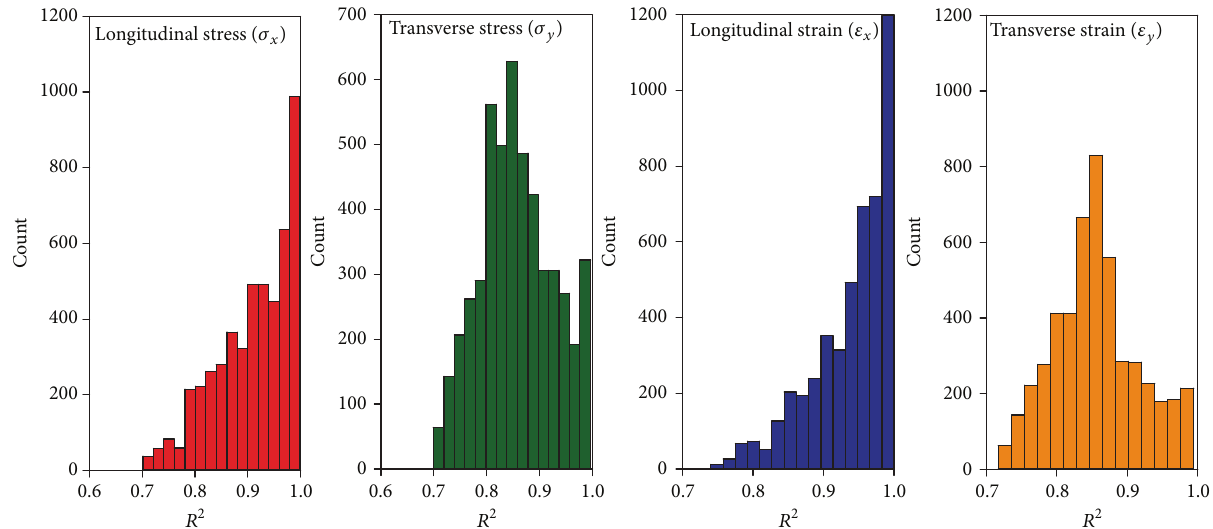
Figure 3: Frequency histogram of coefficient of determination (𝑅 2 ) resulted from fitting haversine function. Table 2: Statistical data relating to effective length ( 𝐿